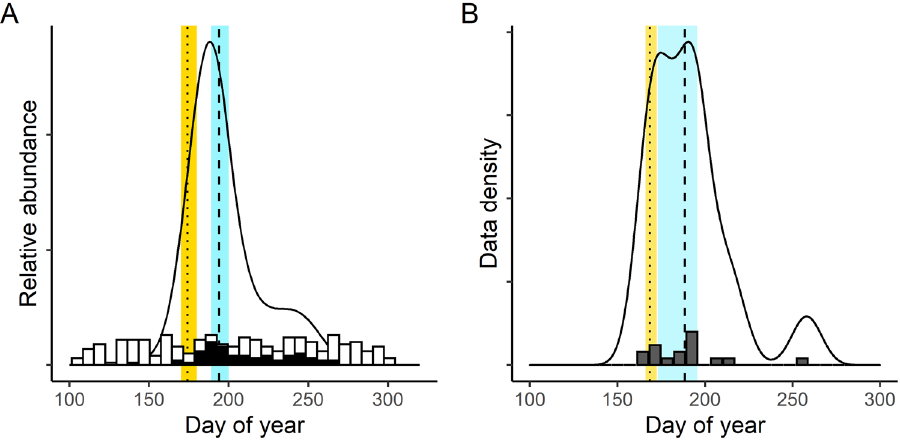
Figure 2. Survey ( A ) and incidental ( B ) data are compiled across day of year (DOY) for each species-year-grid cell unit to estimate a phenogram for the flight period, shown here for Speyeria cybele . In both panels, the black curve shows the flight phenograms calculated using appropriate analytical techniques: GAMs for survey data integrating phenological patterns across sites ( A ) and quantiles for incidental data aggregated across the grid cell ( B ). Our primary response variable for each analysis is the DOYs when 10% (dotted) and 50% (dashed) of butterflies have been counted, shown here with 95% confidence intervals [for 10% DOY estimate in yellow, 50% in blue]. The histogram in each panel shows underlying data: in ( A ) the number of surveys per week, where dark fill represents surveys which recorded the target species and in ( B ), the number of occurrence records per week.